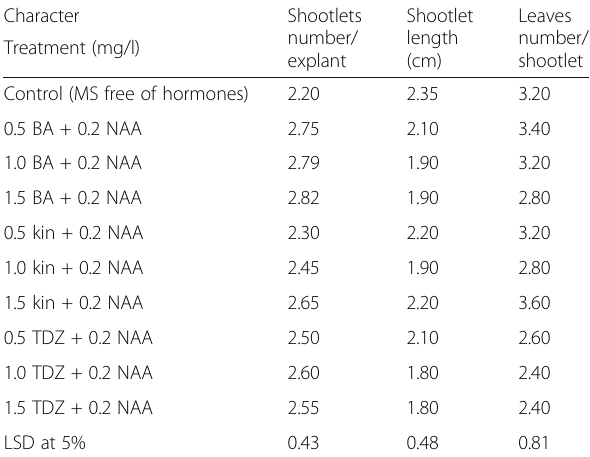
Table 1 Effect of different types of cytokinin at different concentrations on shooting behavior of Ceratonia siliqua